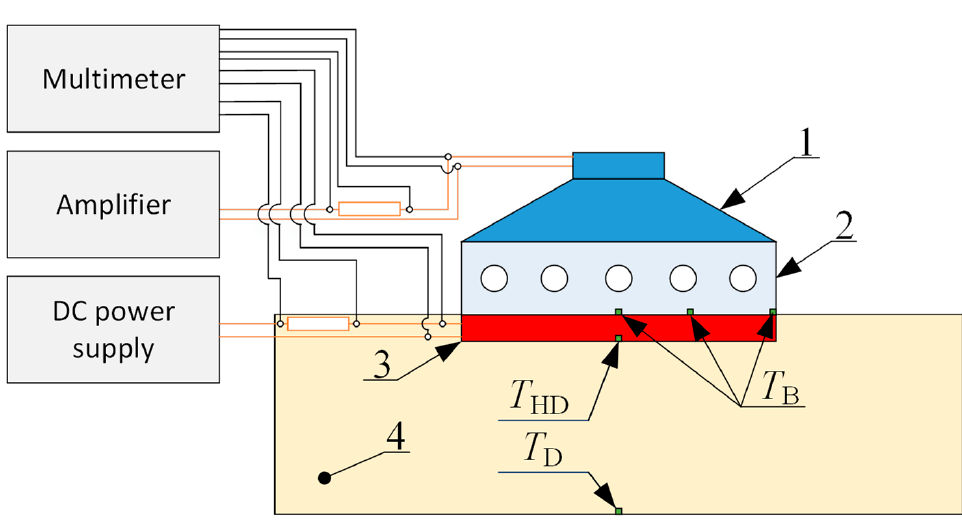
Figure 2. Schematic diagram of the experimental setup: 1—loudspeaker, 2—heat sink with outer ring, 3—heater, 4—insulation.